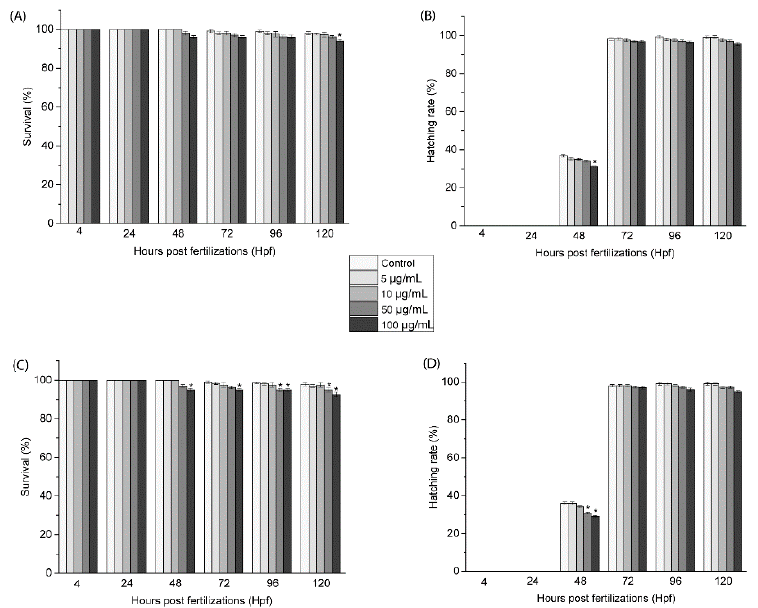
Figure 7. Survival rates ( A – C ) and hatching rates ( B – D ) of embryos exposed to different concen- trations of BN- and oxi-BN-CNOs (5, 10, 50, and 100 μ g/mL). Data are calculated as means ± S.D., from three independent experiments, n = 80 (* indicate p ≤ 0.01 compared to the control).